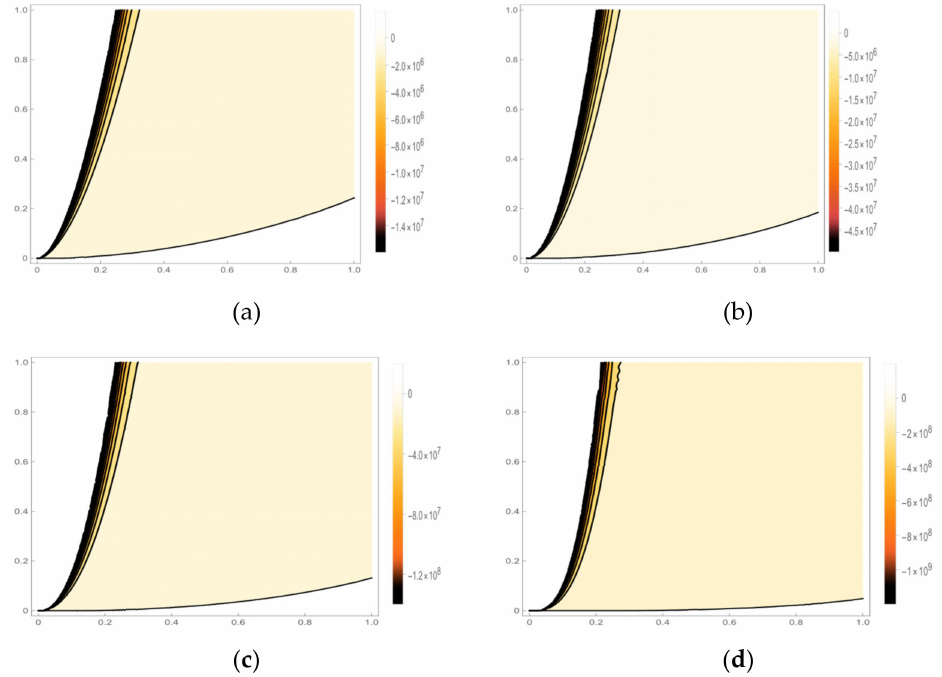
Figure 5. The contour graph of the solution f ( x , t ) of the fractional equation of the cancer tumor module at p = 1.2 and several value of α in Example 3. ( a ) α = 1; ( b ) α = 0.9; ( c ) α = 0.8; ( d ) α =